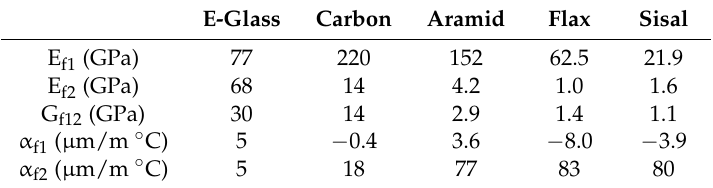
Table 2. Comparison of reinforcement fibre thermoelastic properties at room temperatures [22].